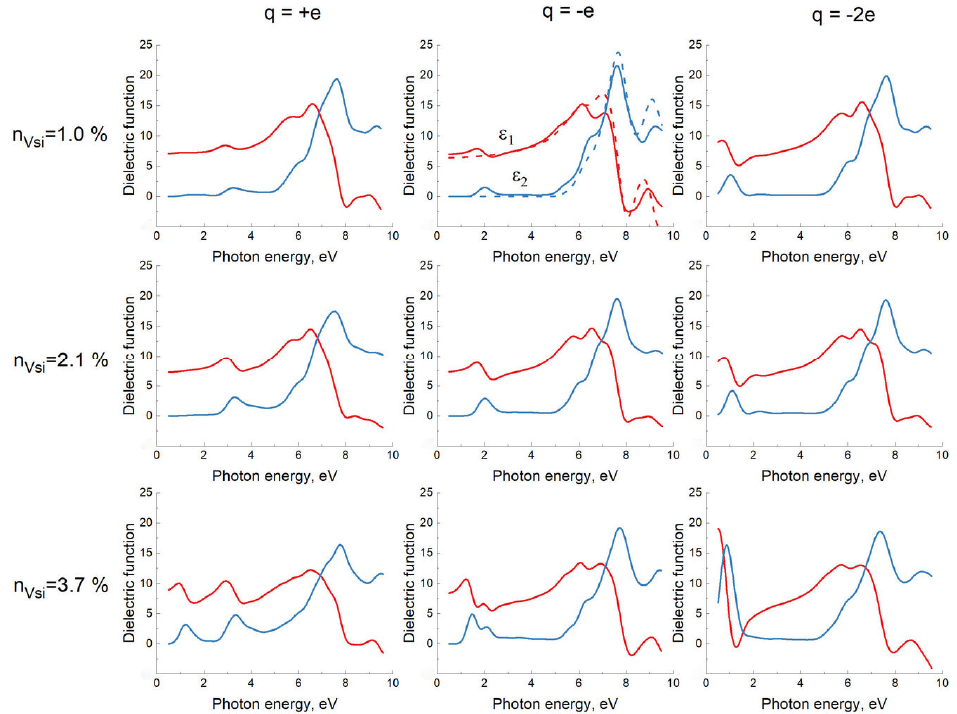
Figure 9. Dielectric function of 3C–SiC containing silicon vacancies with different concentrations n V and different charges q , as calculated by the DFT method. The red color shows the real part ε 1 and the blue color shows the imaginary part ε 2 . In the middle of the upper row, the dashed line shows the dielectric function of an ideal 3C–SiC.